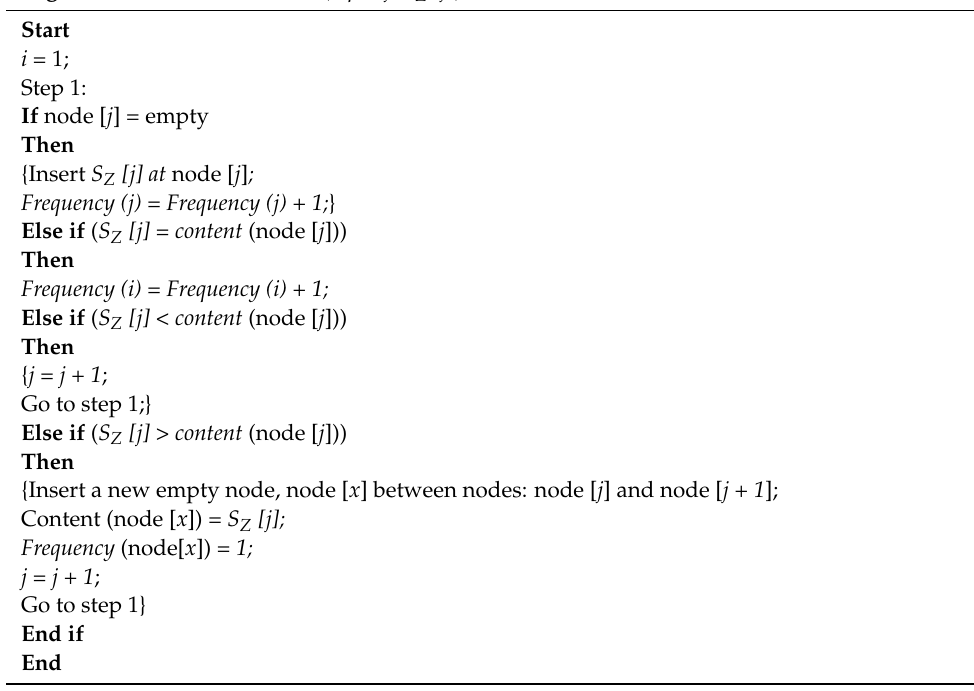
Algorithm 2. Z-Tree-insertion ( input j , S Z [j]